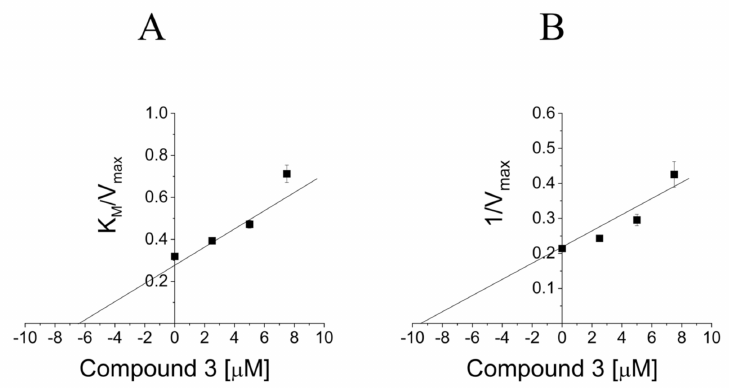
Figure 6. Secondary plots. K M /V max ( A ) and 1/V max ( B ) versus the inhibitor concentration, respec- tively. The intercept of straight line with the “x” axis in Panel A, represents the Ki value, while the intercept of straight line with the “x” axis in Panel B represents the Ki (cid:48) value (Ki (cid:48) = α Ki). The symbols (cid:4) represent respectively the slopes ( A ) and the intercepts ( B ) of the straight lines shown in Figure